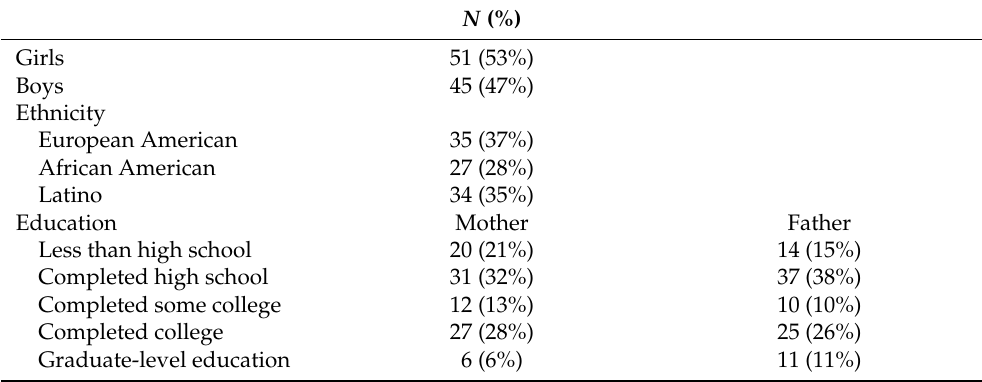
Table 1. Demographic characteristics of